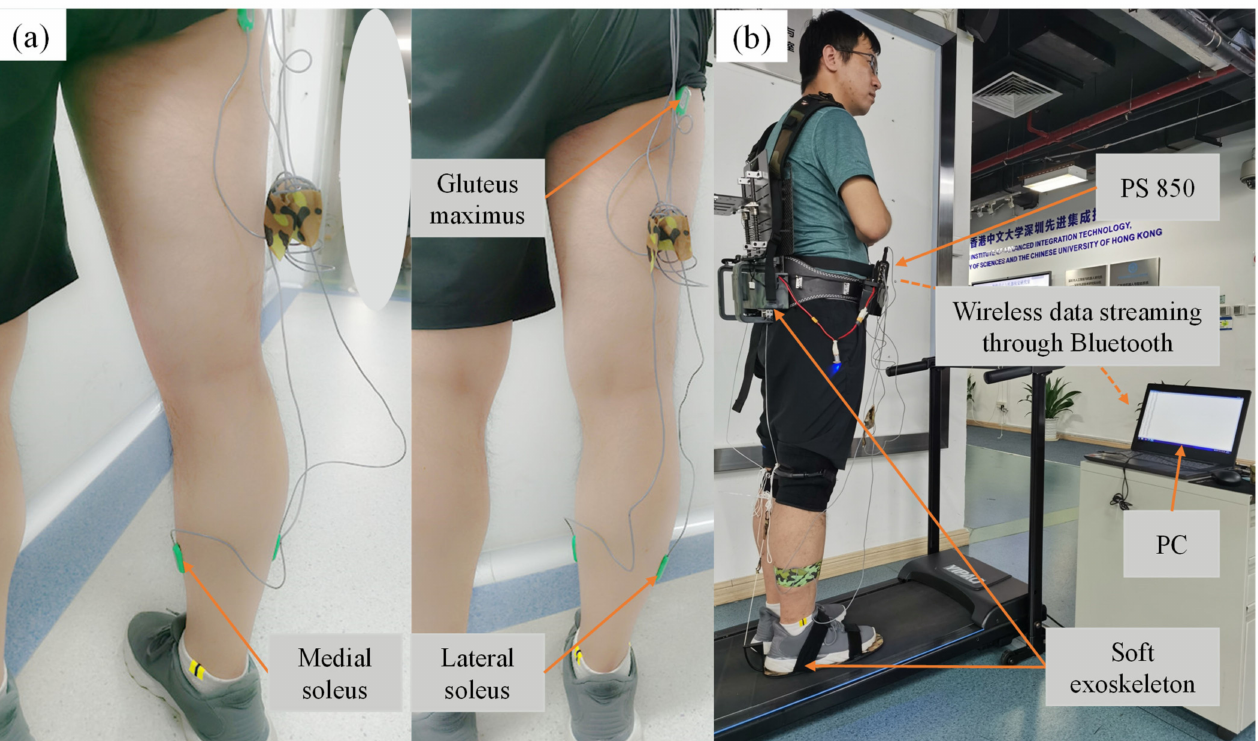
Figure 5. The position of the EMG electrodes on the leg and test scheme. ( a ) EMG electrodes on the leg, ( b ) test